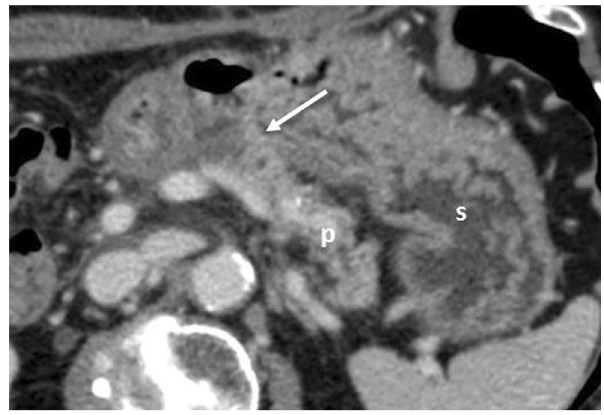
Fig. 6 Pancreaticogastrostomy. The pancreas (p), stomach (s) and pancreaticogastrostomy (white arrow) are visible after a